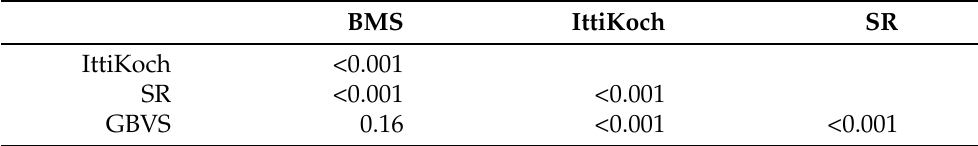
Figure 6. MAE between the saliency maps computed with different saliency models and the segments containing traffic participants. Table 3. Nemenyi pairwise test for